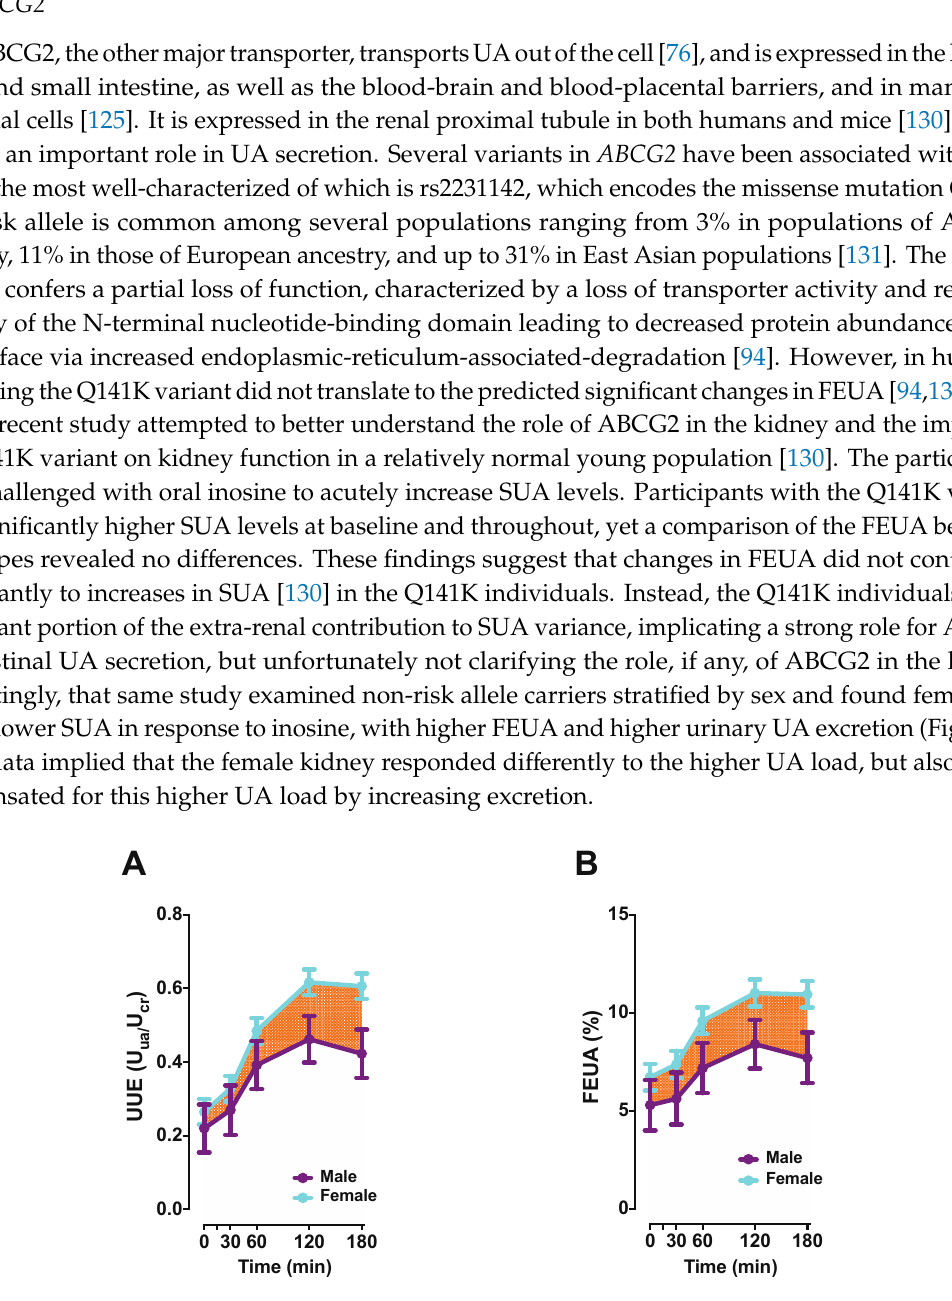
Figure 2. Effect of sex on urinary urate excretion (UUE) ( A ), and fractional excretion of urate (FEUA) ( B ) in participants following inosine load (79 participants; ± SD of mean). Statistical significance evaluated by a two-tailed ANCOVA, adjusted for age, ancestry, and BMI. ACOVA P (time) < 0.0001, P (sex) < 0.0001 for Panels ( A , B ), ACOVA P (sex*time) = 0.038 ( A ) and P (sex*time) = 0.45 ( B ). Adapted from Hoque et al., Nature Communications [130] as allowed under the Creative Commons Attribution 4.0 International License (http://creativecommons.org/licenses/by/4.0/).